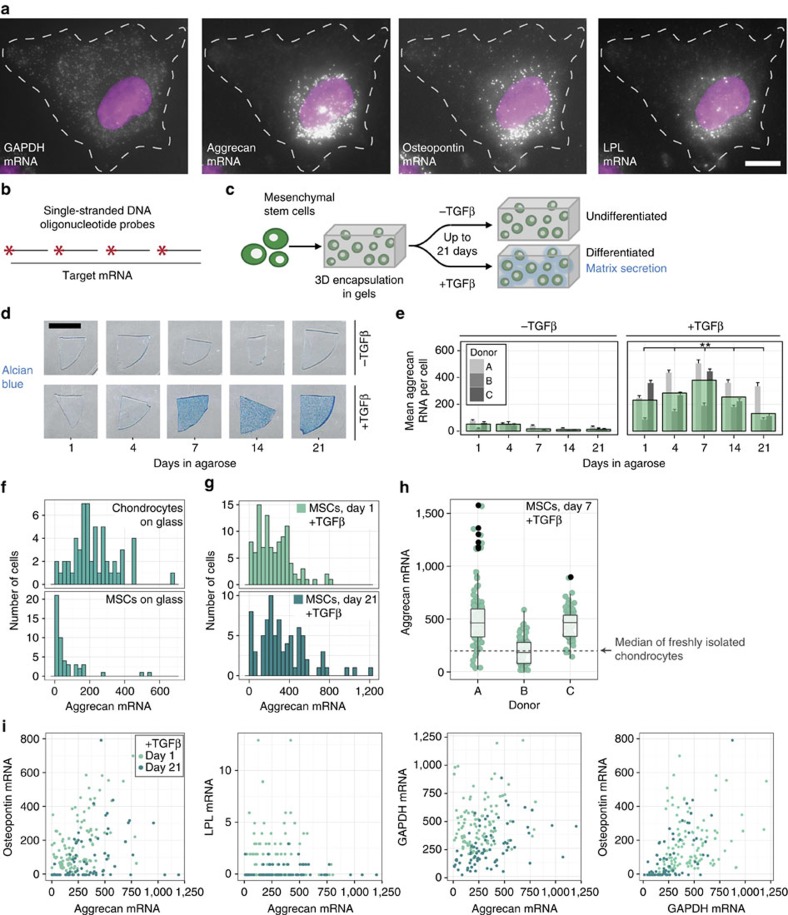
RNA FISH reveals heterogeneity in lineage marker expression in MSCs and chondrocytes.(a,b) Representative images (a) and schematic (b) of single-molecule RNA FISH, in which fluorescently labelled DNA oligonucleotides enable quantification of absolute expression of multiple genes in the same cell. Scale bar, 10 μm. (c) Chondrogenic induction scheme, involving cell encapsulation in 3D agarose constructs and exposure to TGFβ. (d) Alcian blue staining for sulfated proteoglycans; Donor B shown. Scale bar, 5 mm. (e) Mean aggrecan RNA counts in MSCs cultured in 3D for up to 21 days. Narrow bars represent the mean within an individual donor; overlaid bars represent the mean across donors. Error bars indicate standard error (n=24–128 cells per donor and condition). Means compared by t-tests with Satterthwaite approximation and simulated adjustment for multiple comparisons, **P<0.01 versus −TGFβ conditions, and between +TGFβ time points. See Supplementary Table 4 for all statistical comparisons. (f,g) Distributions of single-cell aggrecan expression for chondrocytes and MSCs plated on glass in basal media (f, n=56 chondrocytes, 49 MSCs) and 3D encapsulated MSCs exposed to TGFβ for 1 and 21 days (g, n=105 cells for day 1, 79 cells for day 21; Donor A shown.) (h) Single-cell aggrecan expression for each donor after 7 days of 3D culture with TGFβ relative to the median aggrecan expression in freshly isolated chondrocytes (dashed line; n=103 cells for Donor A, 54 cells for Donor B and 65 cells for Donor C). (i) Simultaneous expression of aggrecan, osteopontin, LPL and GAPDH on day 1 and day 21; Donor A shown (n=105 cells for day 1, 79 cells for day 21).